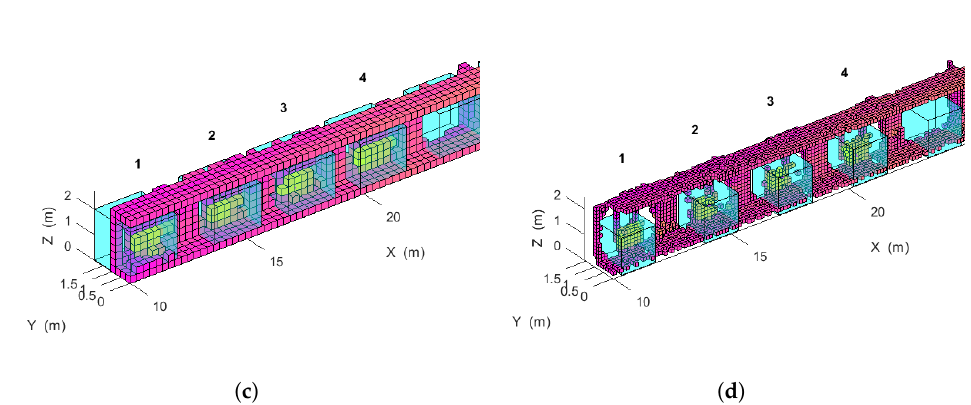
Figure 10. ( a ) Voxel clusters detected, with a threshold temperature of 37.5 ◦ C, on the left side of the low resolution temperature distribution map relative to the indoor test environment. ( b ) Voxel clusters detected, again with a threshold temperature of 37.5 ◦ C, on the left side of the high resolution temperature distribution map relative to the indoor test environment. ( c ) Detail of the clusters in the low resolution indoor temperature distribution map. ( d ) Detail of the clusters in the high resolution indoor temperature distribution map.